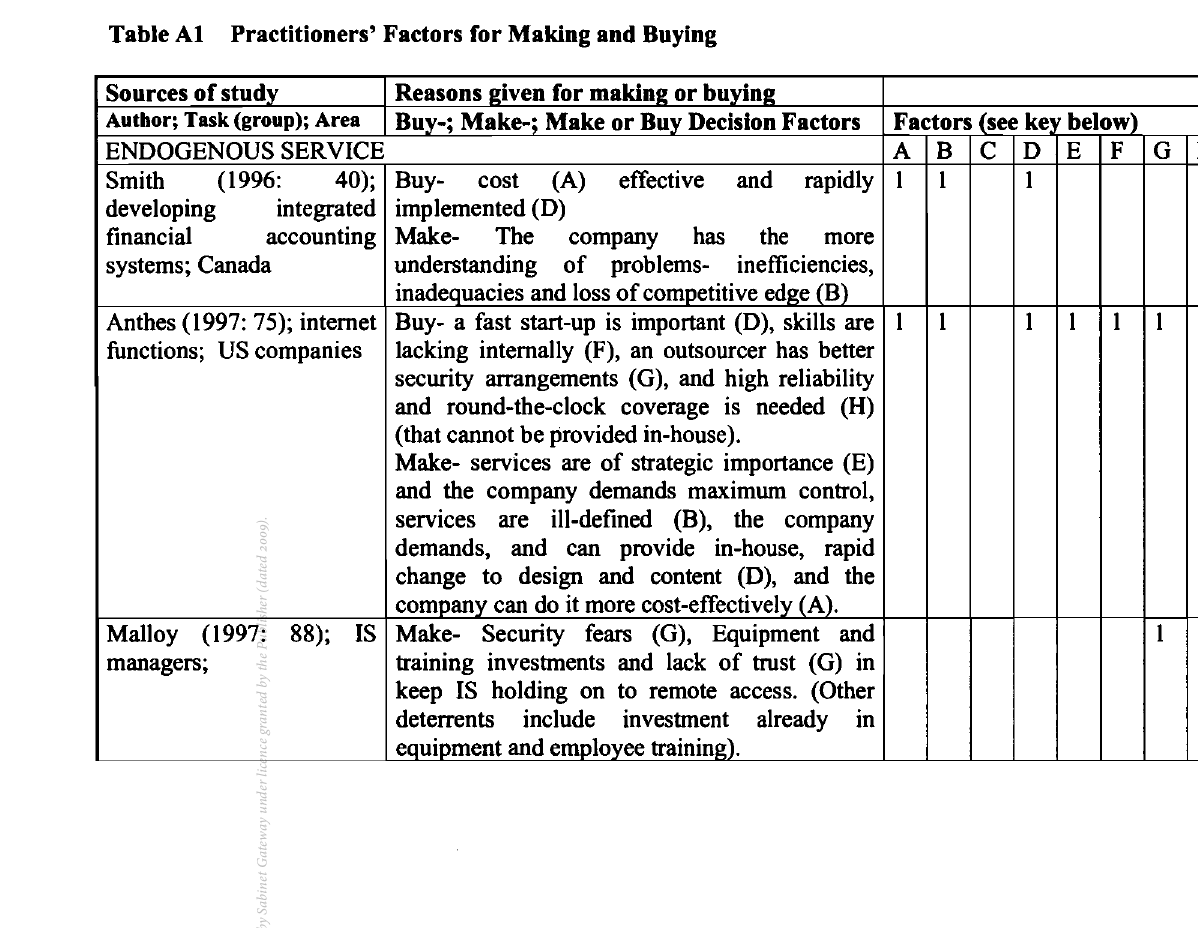
Table Al Practitioners' Factors for Making and Buying Sources of